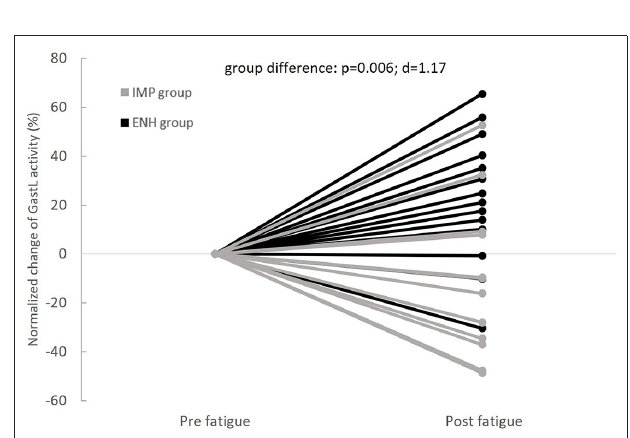
FIGURE 5 | Individual evolutions of normalized change in Gastrocnemius Lateralis (GastL) activity with fatigue between groups (IMP, impaired-stability group; ENH, enhanced-stability